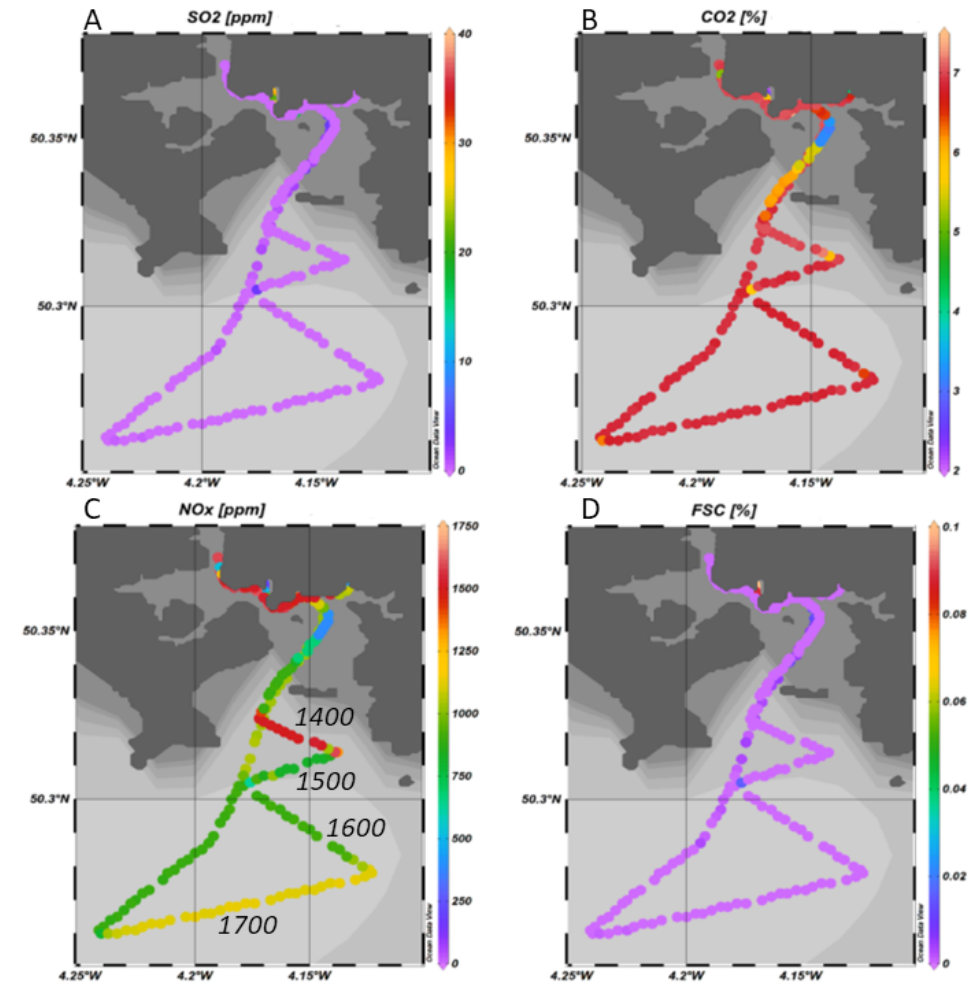
Figure 4. Trial 1—spatial variability in RV Plymouth Quest emissions of ( A ) SO 2 (ppm), ( B ) CO 2 (% vol), ( C ) NO x (ppm), and ( C ) fuel sulphur content (FSC—%). Numbers in (C) show the engine rpm for the different legs of the return journey. Data are presented using Ocean Data View .